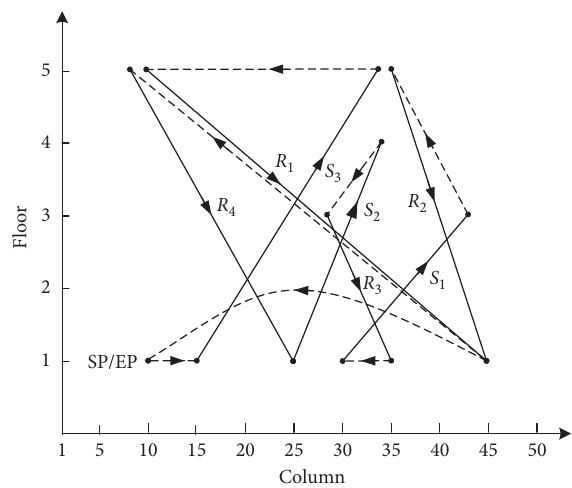
Figure 13: An example of subloops after equivalent merging: the horizontal axis and the vertical axis represent the column and floor, where the stacker access point is located, respectively, the solid line represents load travel, and the dotted line represents no-load travel.